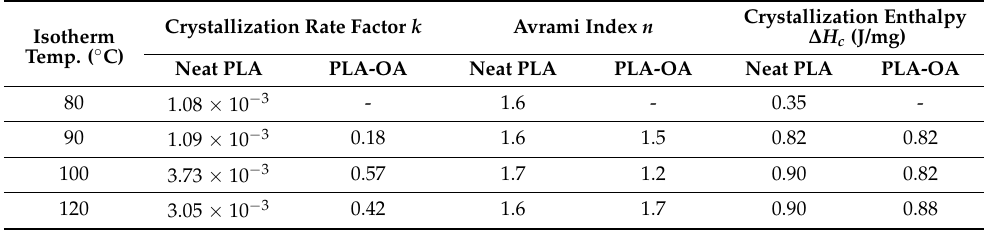
Table 4. The k , n , ∆ H c values obtained from the Avrami heat flow curve fitting scheme. Crystallization Rate Factor k Avrami Index Isotherm Temp. ( ◦ C)